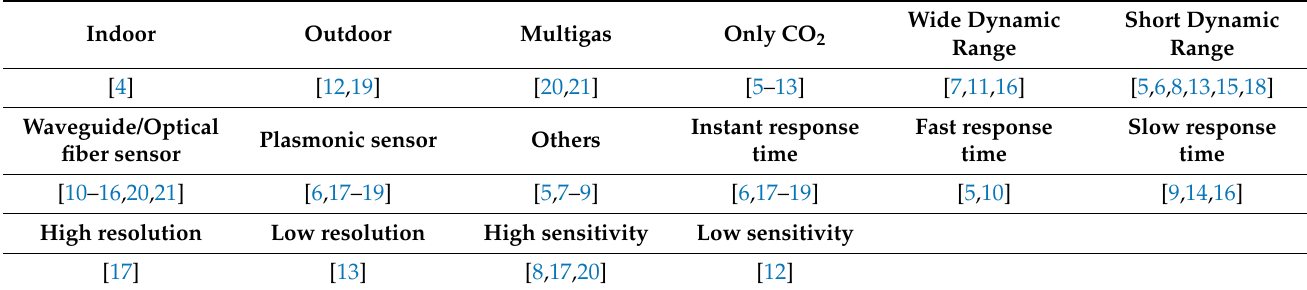
Table 1. Summary table with the essential characteristics of the sensors studied.